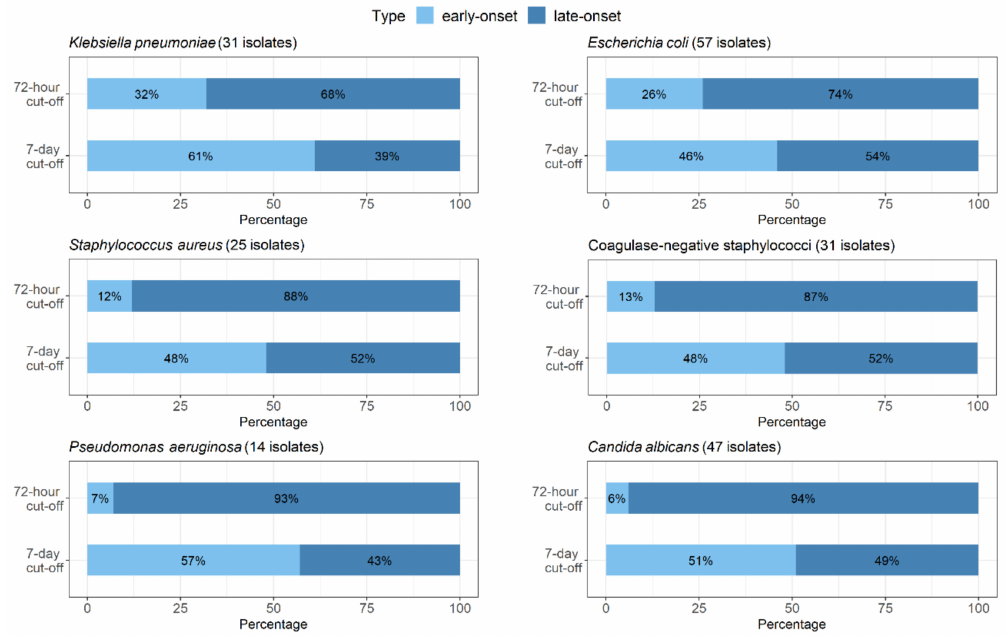
Figure 1. Proportional representation of early- and late-onset infections with regard to both cut-offs (72-h and 7-day) shown for Klebsiella pneumoniae , Escherichia coli , Staphylococcus aureus , coagulase-negative staphylococci, Pseudomonas aeruginosa, and Candida albicans .